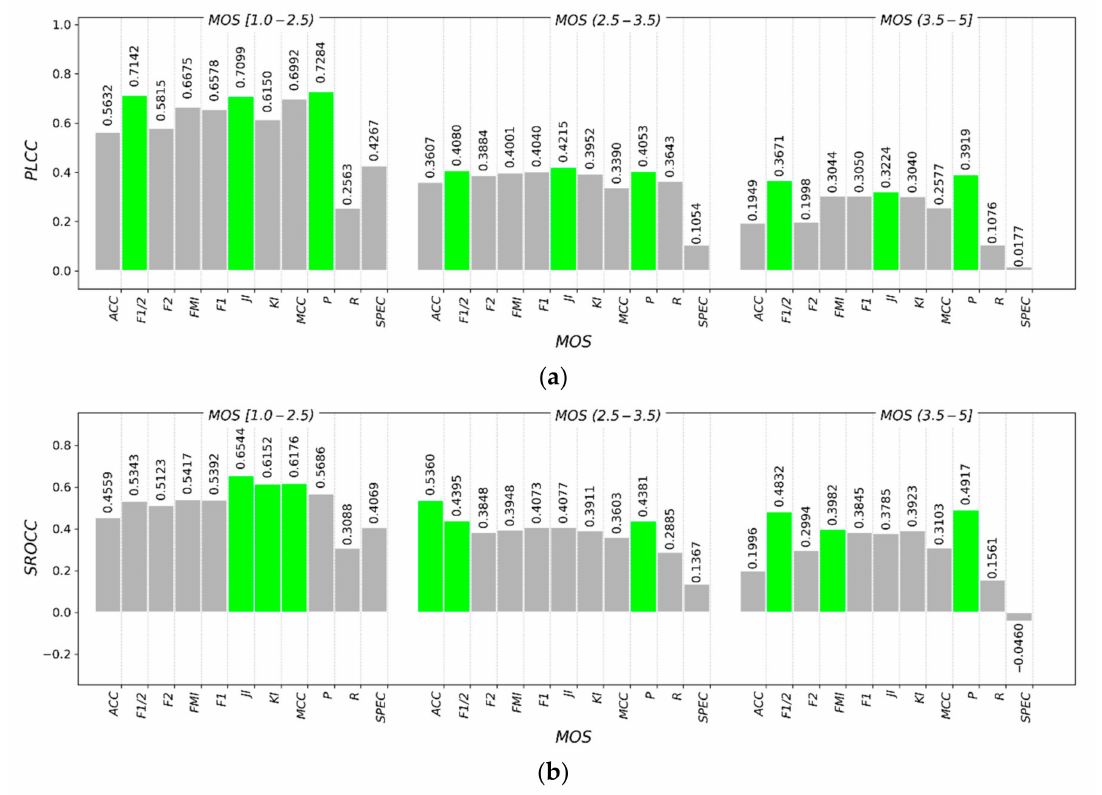
Figure 8. Comparison of the correlation values between di ff erent quality groups of MOS scores and external validation scores (the top three best results are highlighted in light green for each quality group): ( a ) PLCC , and ( b ) SROCC . Table 12. Correlation between di ff erent quality groups of MOS scores and FR-IQA measures (the top three best results are highlighted for each quality